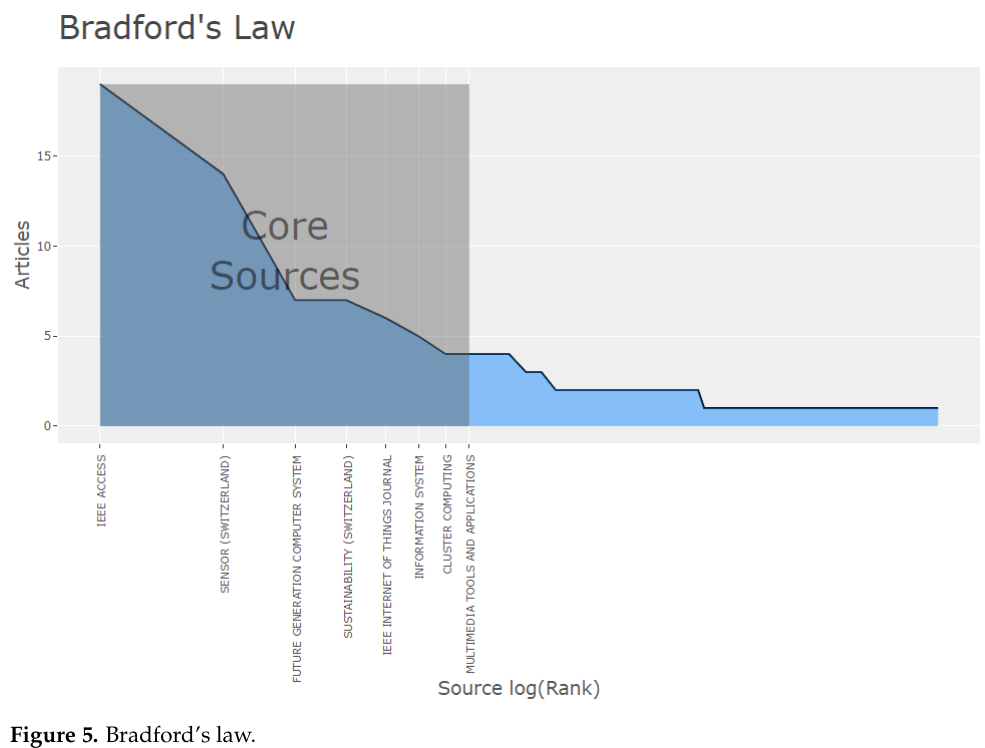
Figure 5. Bradford’s law.